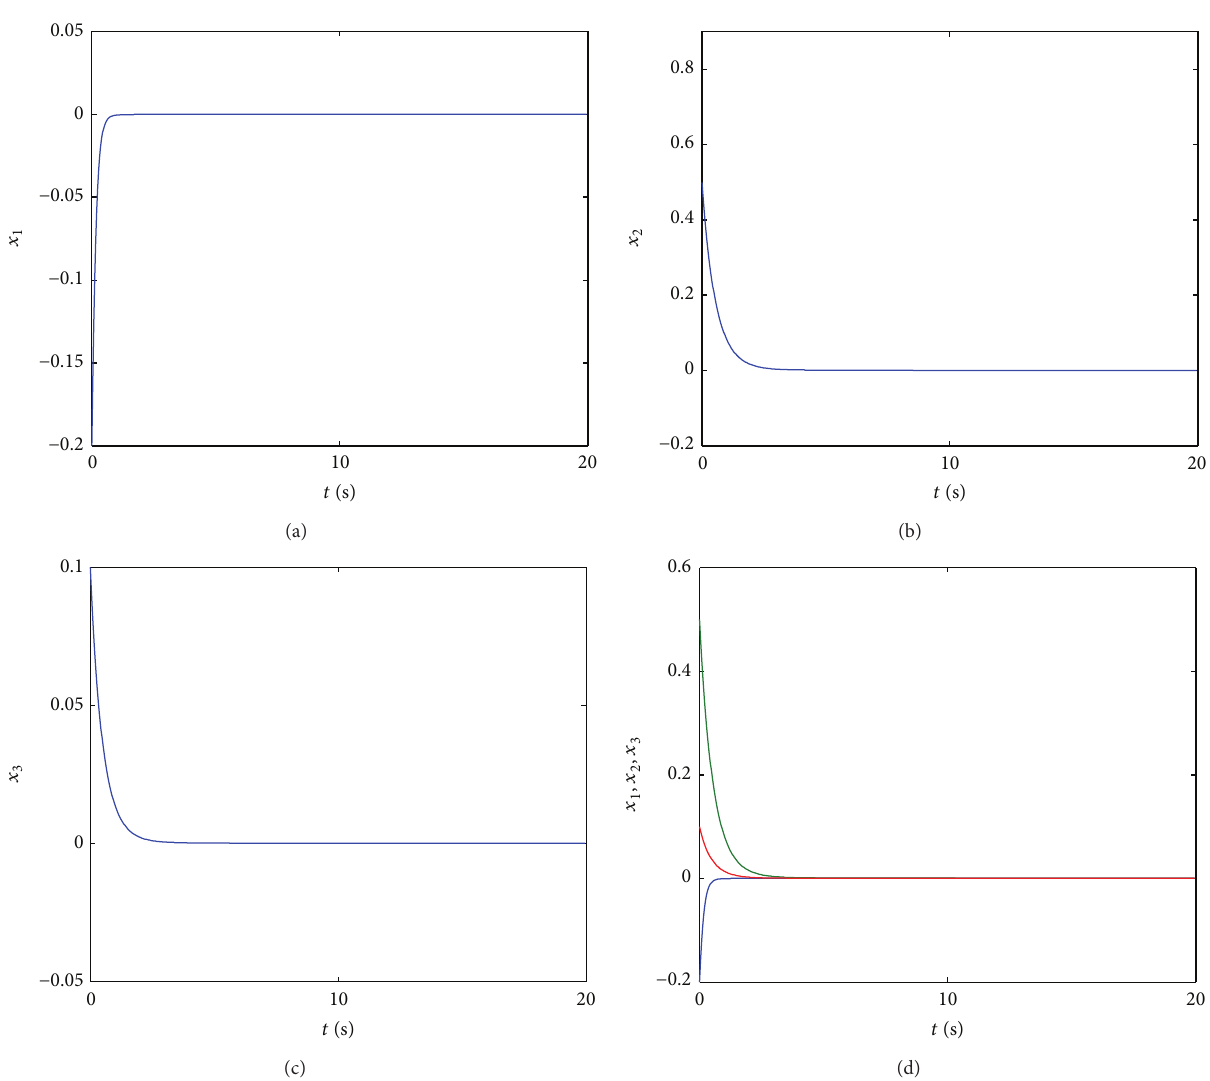
Figure 4: Time waveforms of state variables 𝑥 1 (𝑎) , 𝑥 2 (𝑏) , and 𝑥 3 (𝑐) of the controlled fractional order Chua system.